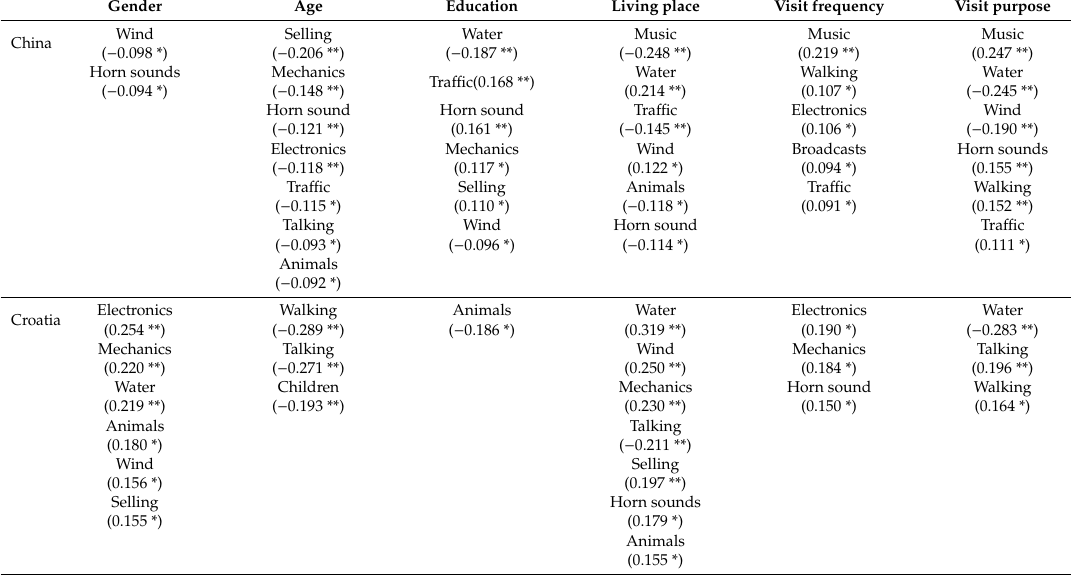
Table 8. Non-parametric test and Spearman’s rho correlation of perceived sound sources and demographic / social factors of gender, age, education, living place, visit frequency and visit purpose. Gender Age Education Living place Visit frequency Visit